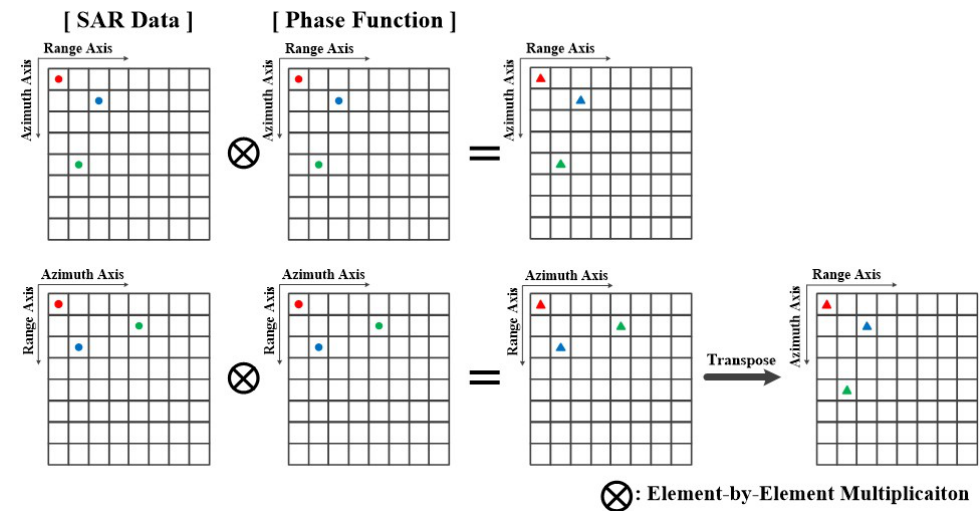
Figure 3. Phase compensation operation with transposed data.